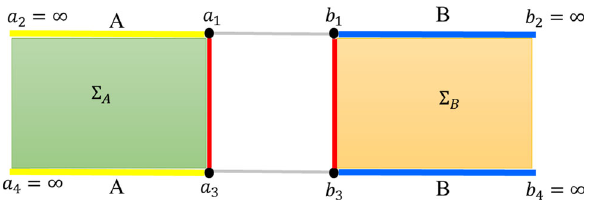
Fig. 3 A two-side static black hole which has two disconnected subre- gions in every boundary. The lines a 4 b 4 and a 2 b 2 stand for the left and rightAdSboundariesand A and B standfortwosubregionsofboundary slices. We assume that the boundary slices lay on t = 0 hypersurface. (cid:3) (cid:3) A and B are extremal co-dimensional-1 surfaces. a 1 a 3 and b 1 b 3 are two RT